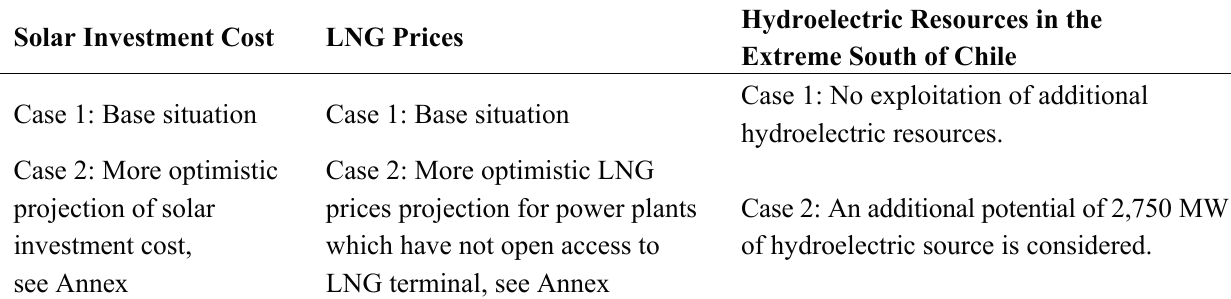
Table 1. Sensitivity analyses considering three sources of